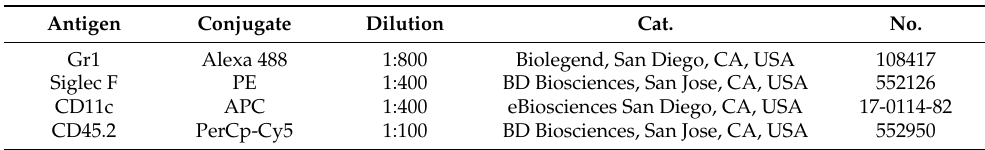
Table 1. Antibodies used for flow cytometry